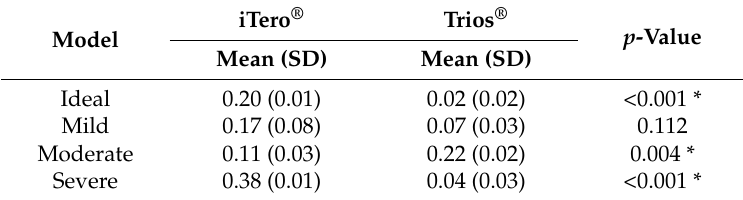
Table 7. Comparison of differences in intermolar widths in iTero ® versus Trios ® (unit: µ m). Model